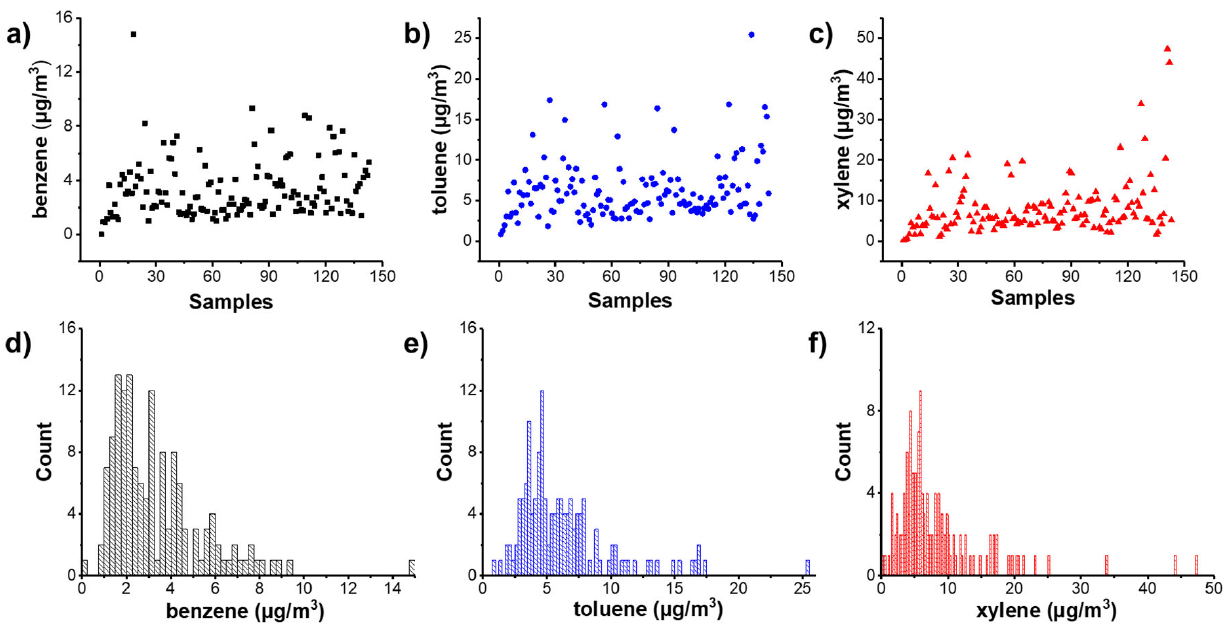
Figure 1. Concentration distributions of ( a , d ) benzene, ( b , e ) toluene, and ( c , f ) xylene in 143 indoor air samples.